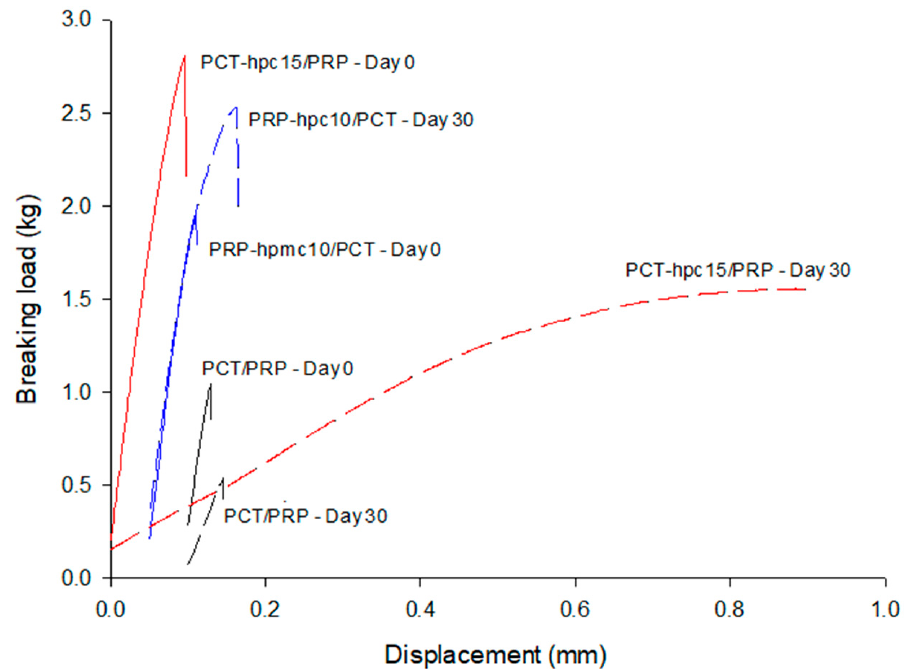
Figure 9. Breaking load against displacement of compression head during diametrical loading for tablets of physical mixture of drugs (PCT/PRP) and CSD/neat drugs at Day 0 and Day 30 (end of stability test). Table 7. Results of fracture test of tablets of optimal combinations: solid fraction, work of failure, Young’s modulus and tensile